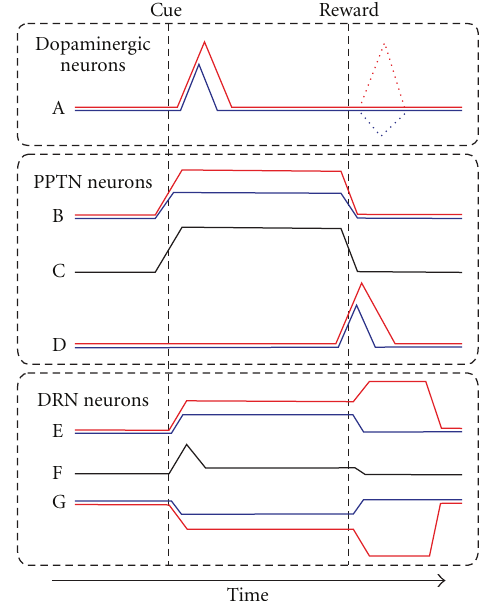
Figure 10: Schematic drawing of the activity changes of dopamin- ergic, PPTN, and DRN neurons for the two-valued saccade task. Cue and reward indicate the timing of reward-cue presentation (either fixation target shape or saccade target location) and large- and small-reward delivery, respectively. The colors indicate the responses in the large-reward trials (red) and small-reward trials (blue) and the responses of neurons with no significant reward modulation (black). (A) Dopaminergic neurons exhibited phasic burst firing to a reward-predictive cue and an unexpected reward (dashed lines). (B, D) Two di ff erent groups of PPTN neurons ex- hibited a tonic reward prediction response (B) and a phasic actual reward response (D). (C) PPTN neurons with no significant reward modulation often exhibited tonic activity during the task period. (E, G) DRN neurons exhibited correlated central fixation and reward modulation, preferring either larger (E) or smaller rewards (G). (F) DRN neurons with no significant reward modulation often exhibited a phasic response to target